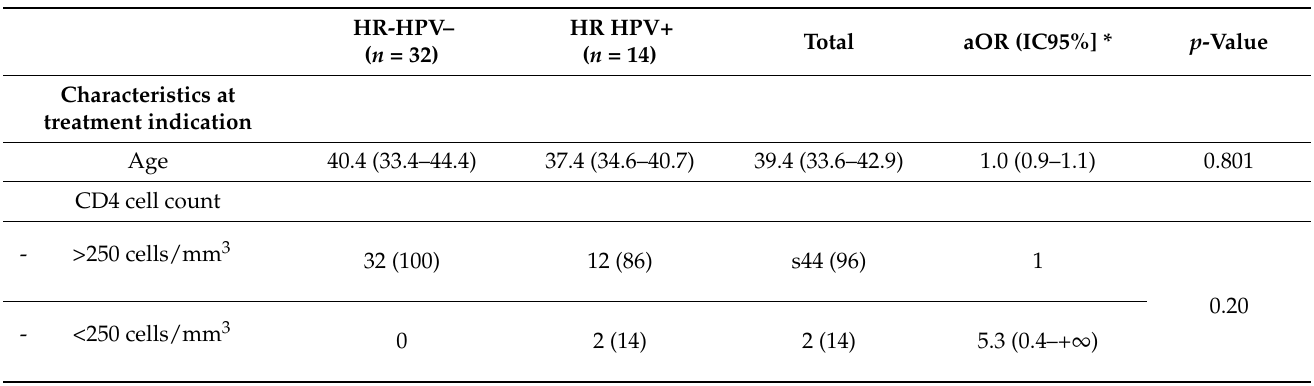
Table A3. Factors associated to the presence of an high-risk HPV infection by the end of the follow up among women presenting with a cervical lesion. Bivariate analyses adjusted on